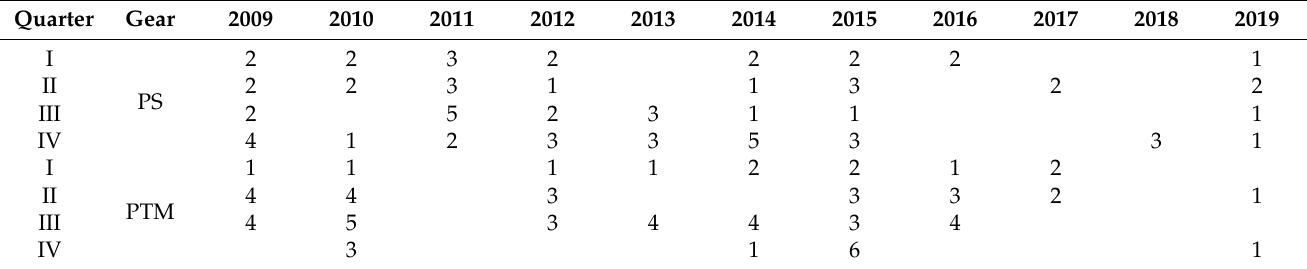
Table 2. Distribution and availability of biological samples collected from landings per quarter (1